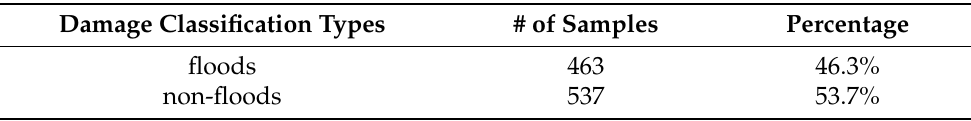
Table 1. Summary of images for the flood damage classification task. The selected 1000 images were divided into two categories for binary